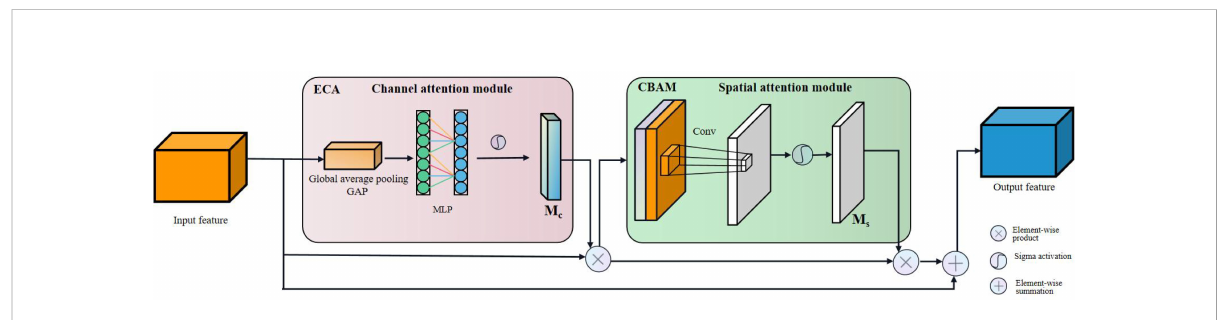
FIGURE 10 The structure of the attention modules.